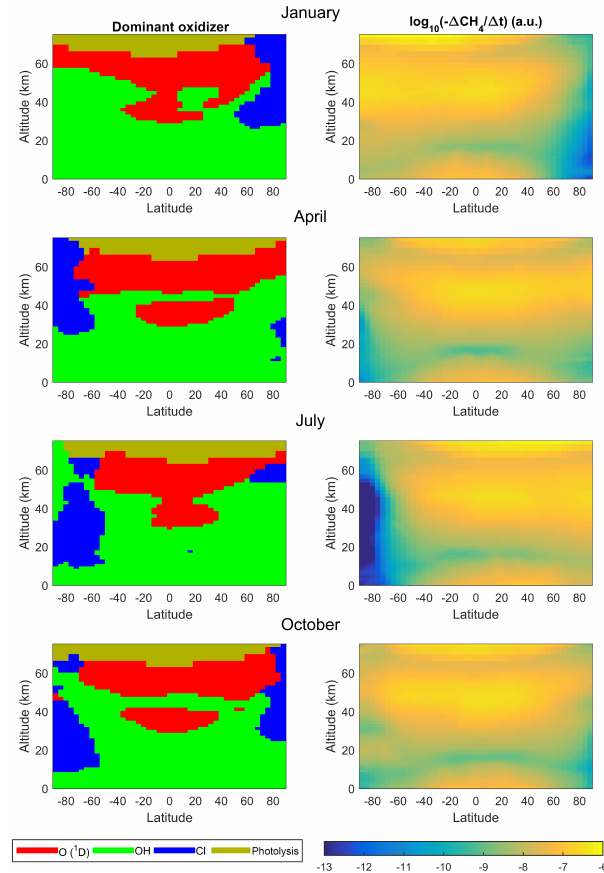
Figure 15. Dominant oxidizing species of CH 4 by location and sea- son (left) and total methane oxidation